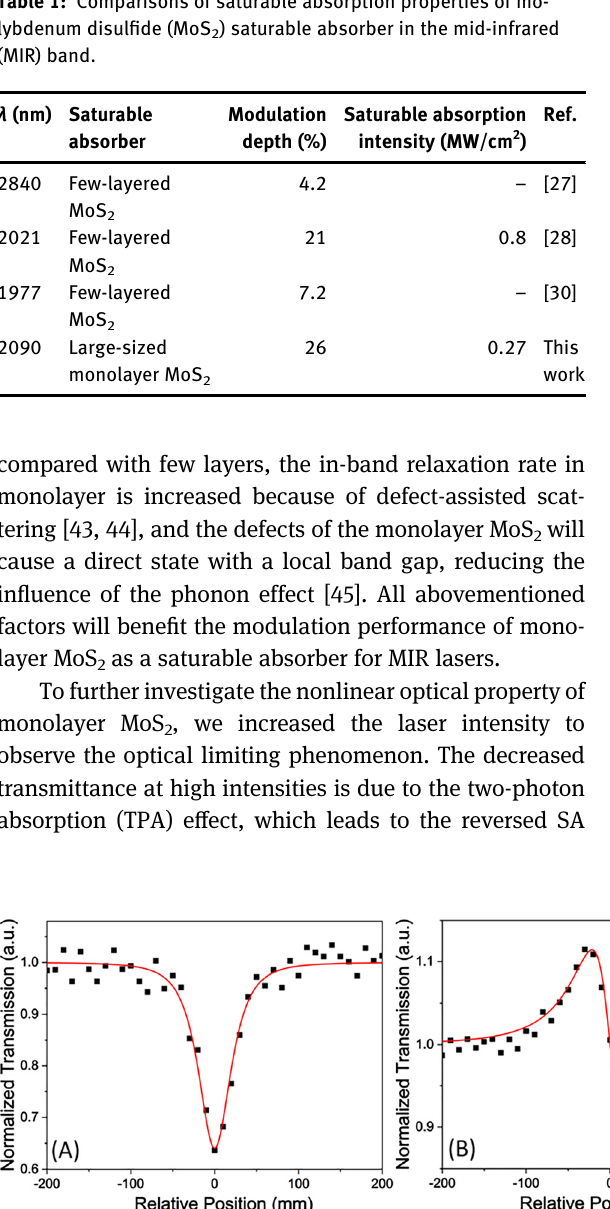
Figure3: (A)Normalizedtransmissionversus the position at the light peak intensity of 1.25 MW/cm 2 and (B) the intensity- dependent nonlinear saturable absorption of single-crystalline monolayer molybde- num disul fi de (MoS 2 ) at 2 μ m.